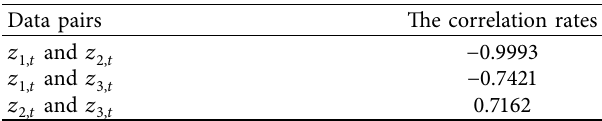
Table 4: Data stationary test z